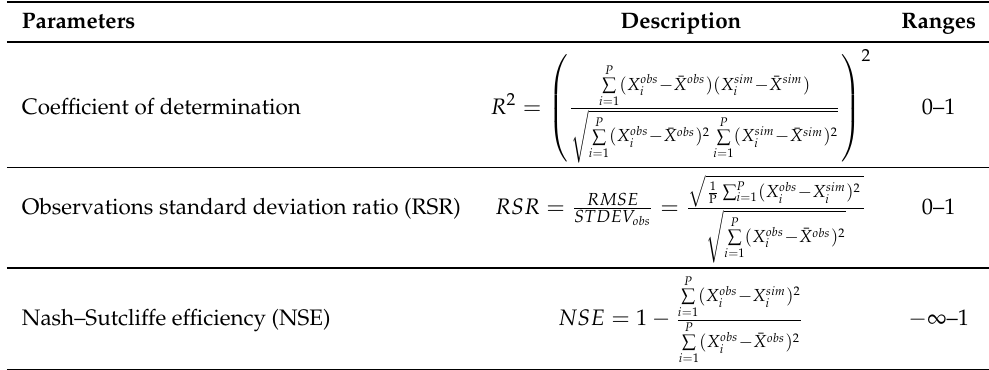
Table 2. Statistical performance parameters used to evaluate the modeling performance.